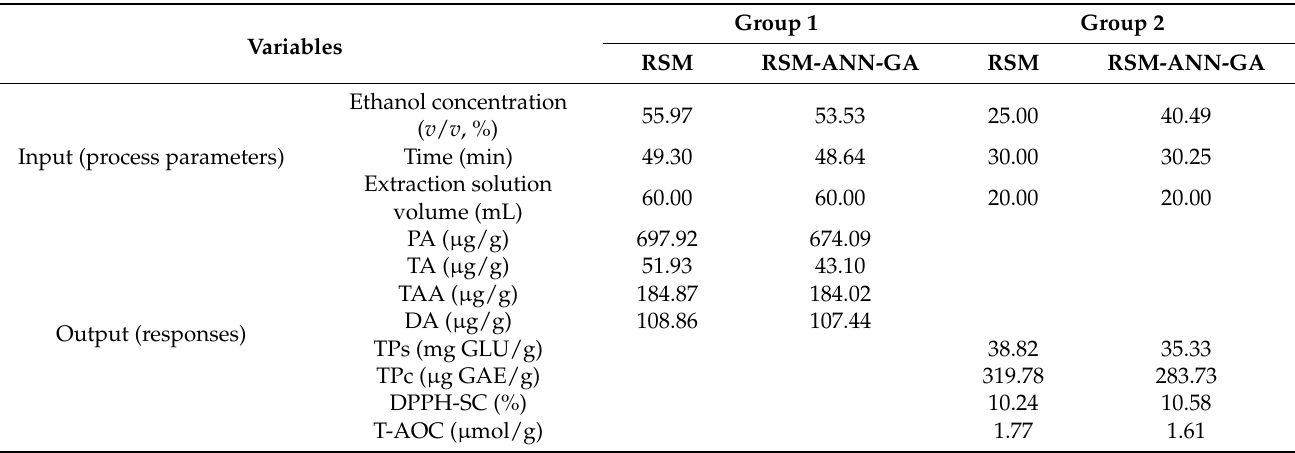
Table 3. Optimized extraction conditions for four triterpenoid acids according to the analysis by RSM and